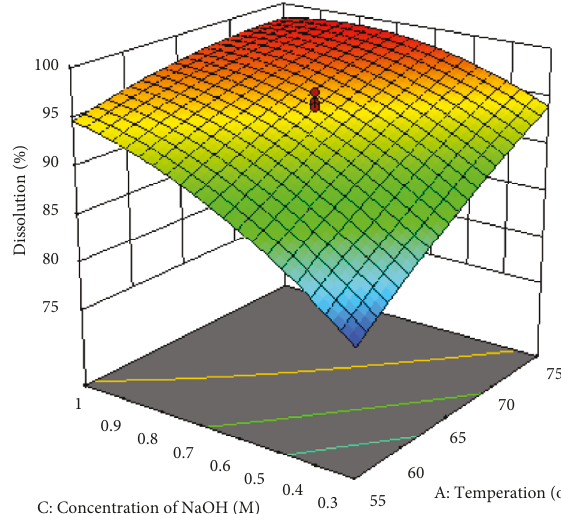
Figure 7: 3-D plot for dissolution percentage showing the inter- action effect of temperature and